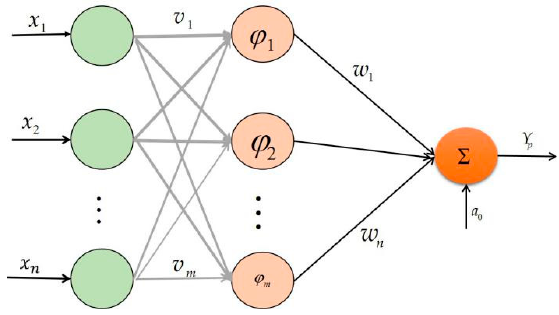
Figure 1. The structure of RBF neural network.